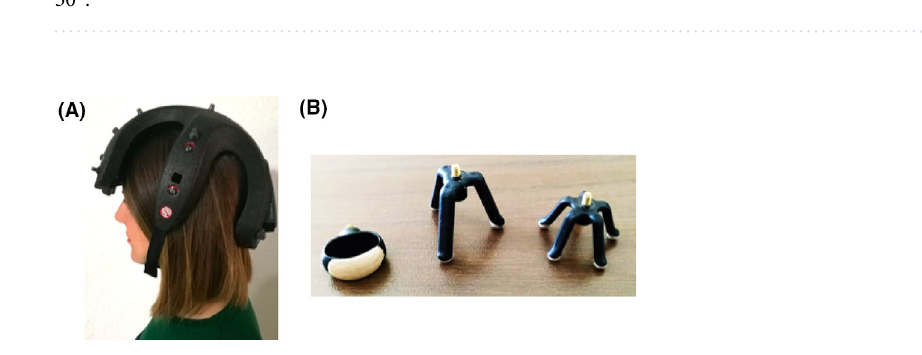
Figure 2. Visual Distractor task elements based on visual Gabor mask with different orientation: 90 ◦ 30